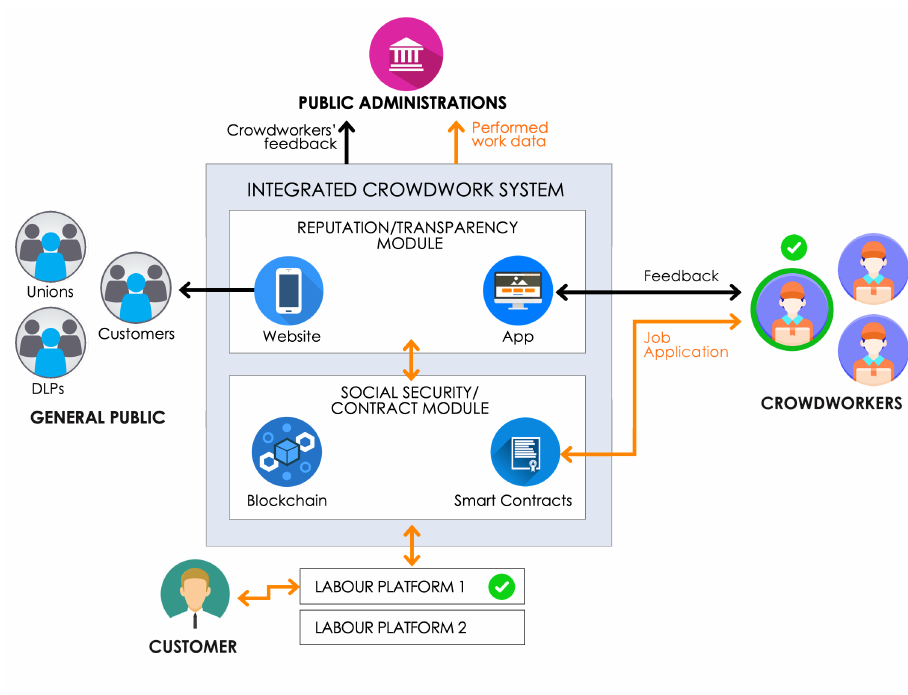
Figure 3. Integrated Crowdwork System : infrastructure. Adapted from